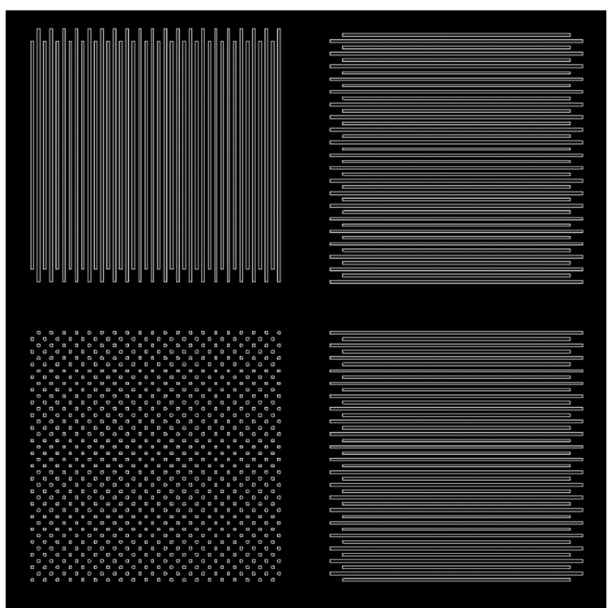
Figure 13. An example of a block with 1D and 2D DSE with 20 periods of diffraction gratings, a base period of 5 µ m, a feature size of 1 µ m and the shift of the second set of gratings ∆ X and ∆ Y of 2.5 µ m. Total block size approx. 200 × 200 µ